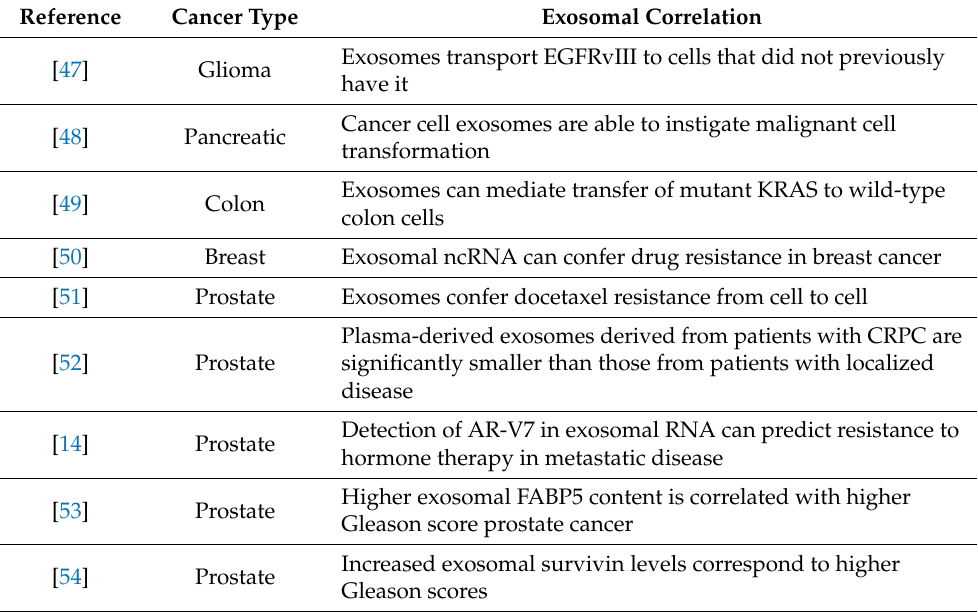
Table 1. Evidence linking exosomes to tumor progression and therapeutic